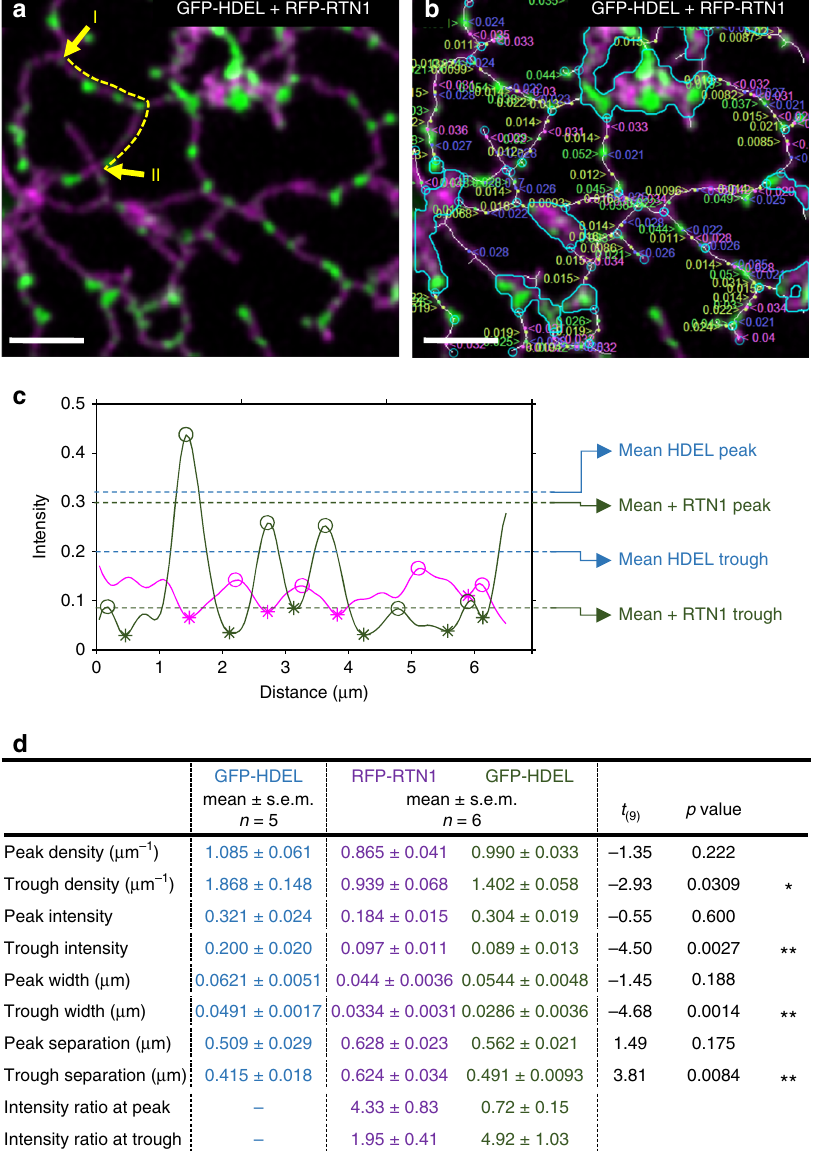
Fig. 2 ER tubule morphology analysis. a A merged two-channel confocal optical section following transient over-expression of RFP-RTN1 (magenta) and GFP-HDEL (green) in tobacco leaf epidermal cells. b Automatic measurement of peaks and troughs for both RFP-RTN1 (left justi fi ed labels, peaks in magenta, troughs in blue) and GFP-HDEL (right justi fi ed labels, peaks in green, troughs in yellow). The underlying pixel skeleton is superimposed in white and the position of nodes indicated in cyan. Cisternae are also outlined in cyan. c Selected trace analysis between the yellow arrows in ( a ) showing the relative intensity for RFP-RTN1 (magenta) and GFP-HDEL (green), with the position of the peaks (open circles) and troughs (asterisks) indicated. The average values for peaks and troughs for the HDEL signal across all experiments are indicated in the presence and absence of RFP-RTN1. d Summary of tubule morphology metrics (mean ± s.e.m.) for GFP-HDEL alone ( n = 5) and co-expressed with RFP-RTN1 ( n = 6), with T -test statistic, associated p -value and signi fi cance, where * p < 0.05 and ** p < 0.01. All scale bars = 5 µ m. Source data are provided as a Source Data fi